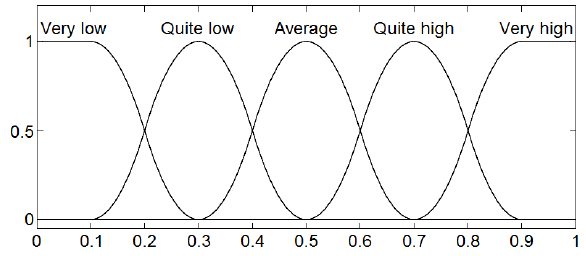
Figure 2: Membership function for the input variable x 1 – PR(Uph) , complex functions (linear quadratic)